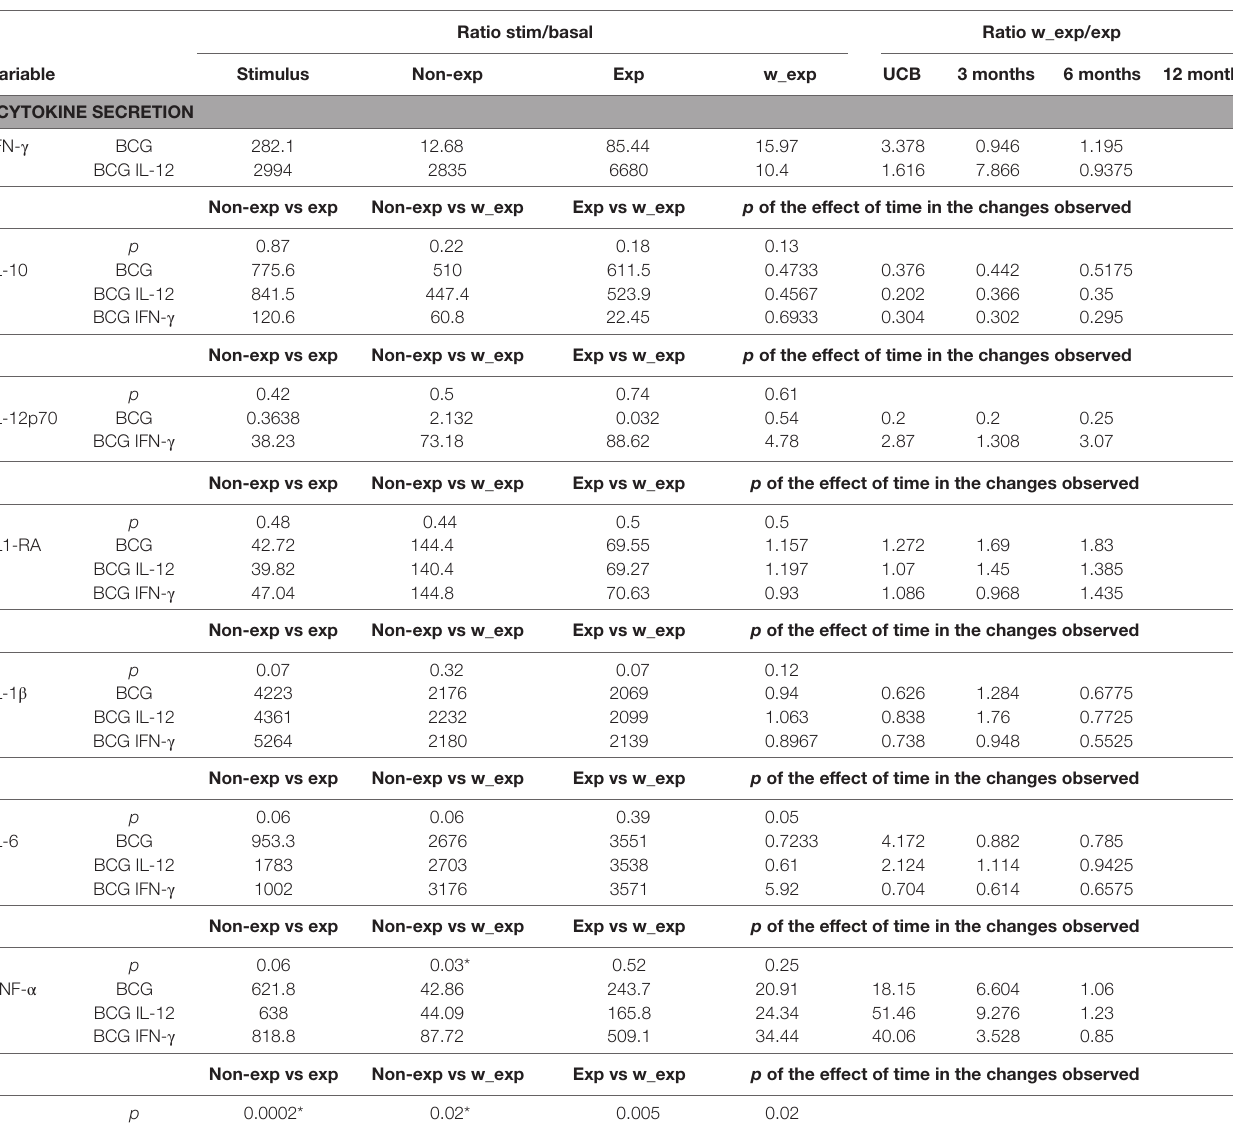
( Figure 3C ). IgG-responses to vaccines (tetanus, diphtheria, and pneumococcus) were normal ( Table 3